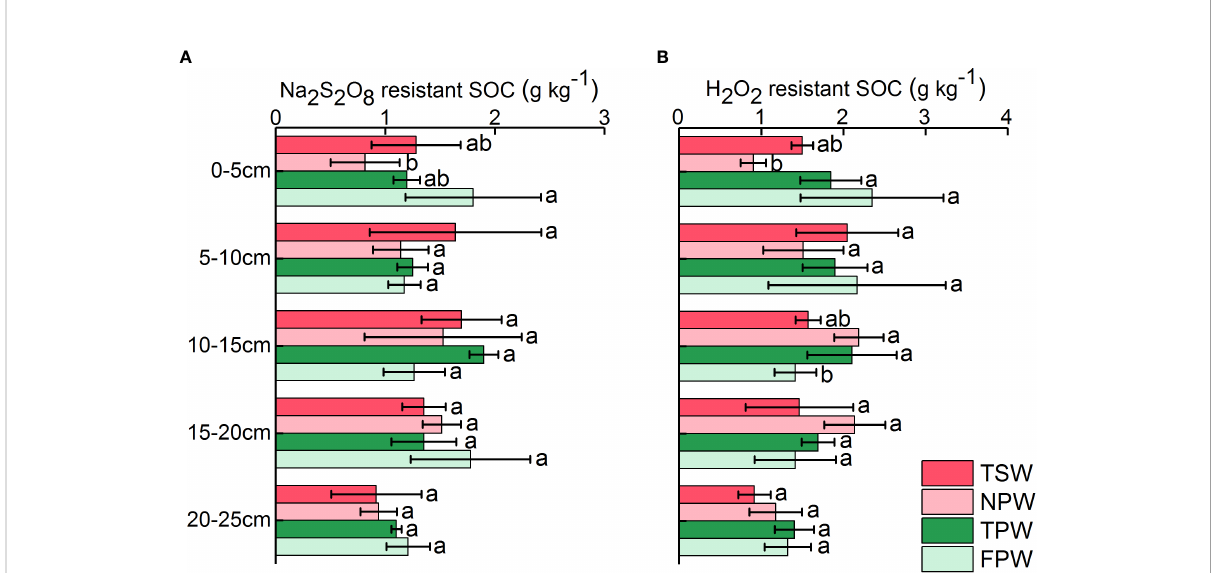
FIGURE 3 Pro fi le distribution of soil Na 2 S 2 O 8 resistant SOC (A) and H 2 O 2 resistant SOC (B) in the four wetlands. (Different lowercase letters represent signi fi cant differences between the same layers of the four wetlands at p < 0.05